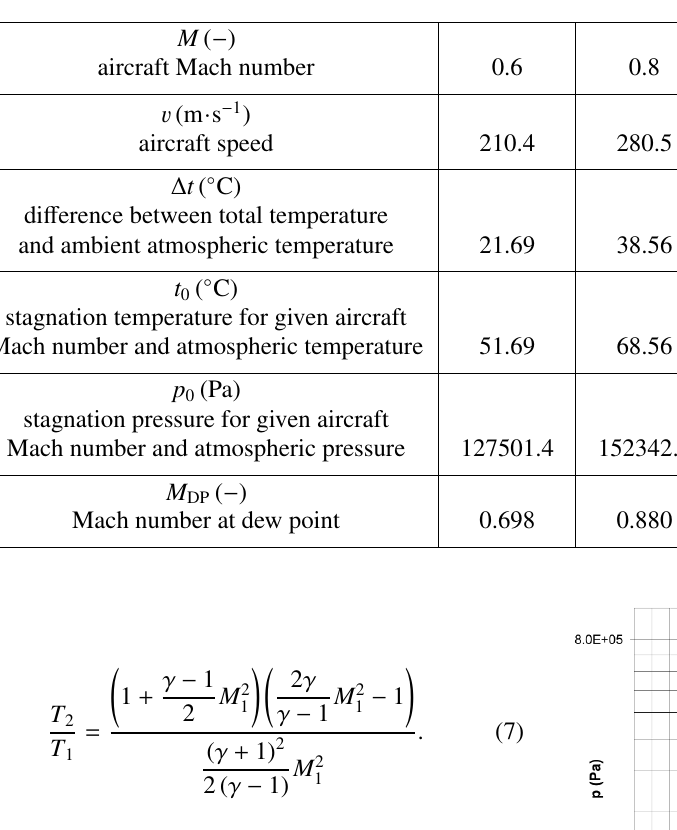
Table 2. Table view of the results shown in Figure 6 including Mach number at dew point for di ff erent values of aircraft Mach number M .